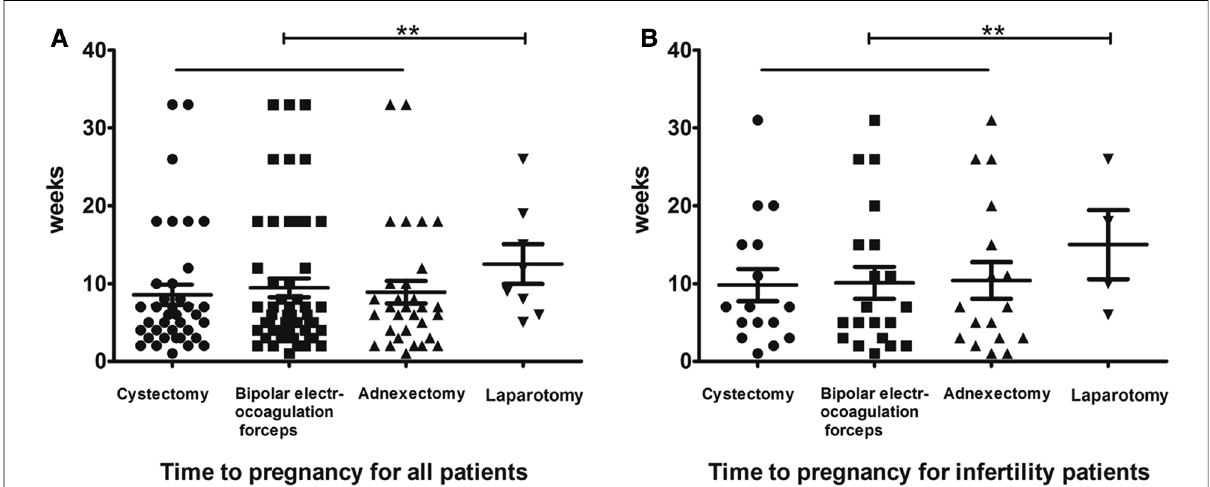
FIGURE 2 Time to pregnancy for all patients ( A ) and infertility patients ( B ). Cystectomy is indicated by bold dots, bipolar electrocoagulation forceps by square dots, adnexectomy by erected triangle dots, and laparotomy by inverted triangle dots. **indicates P